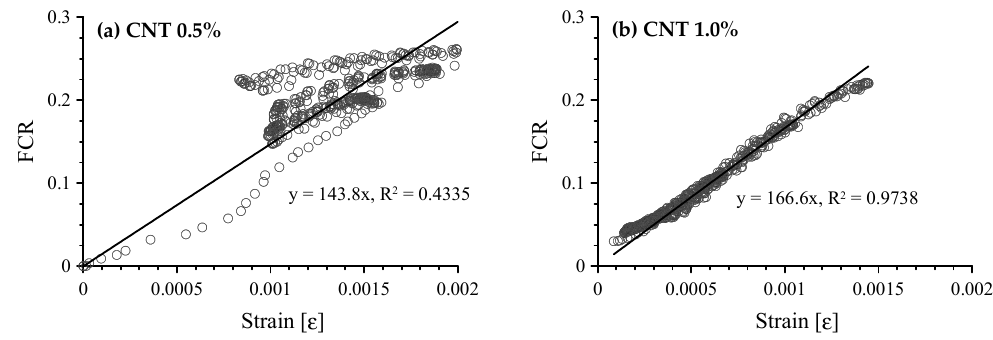
Figure 12. Correlation between FCR and compressive strain of cement-based composites with 0.5 and